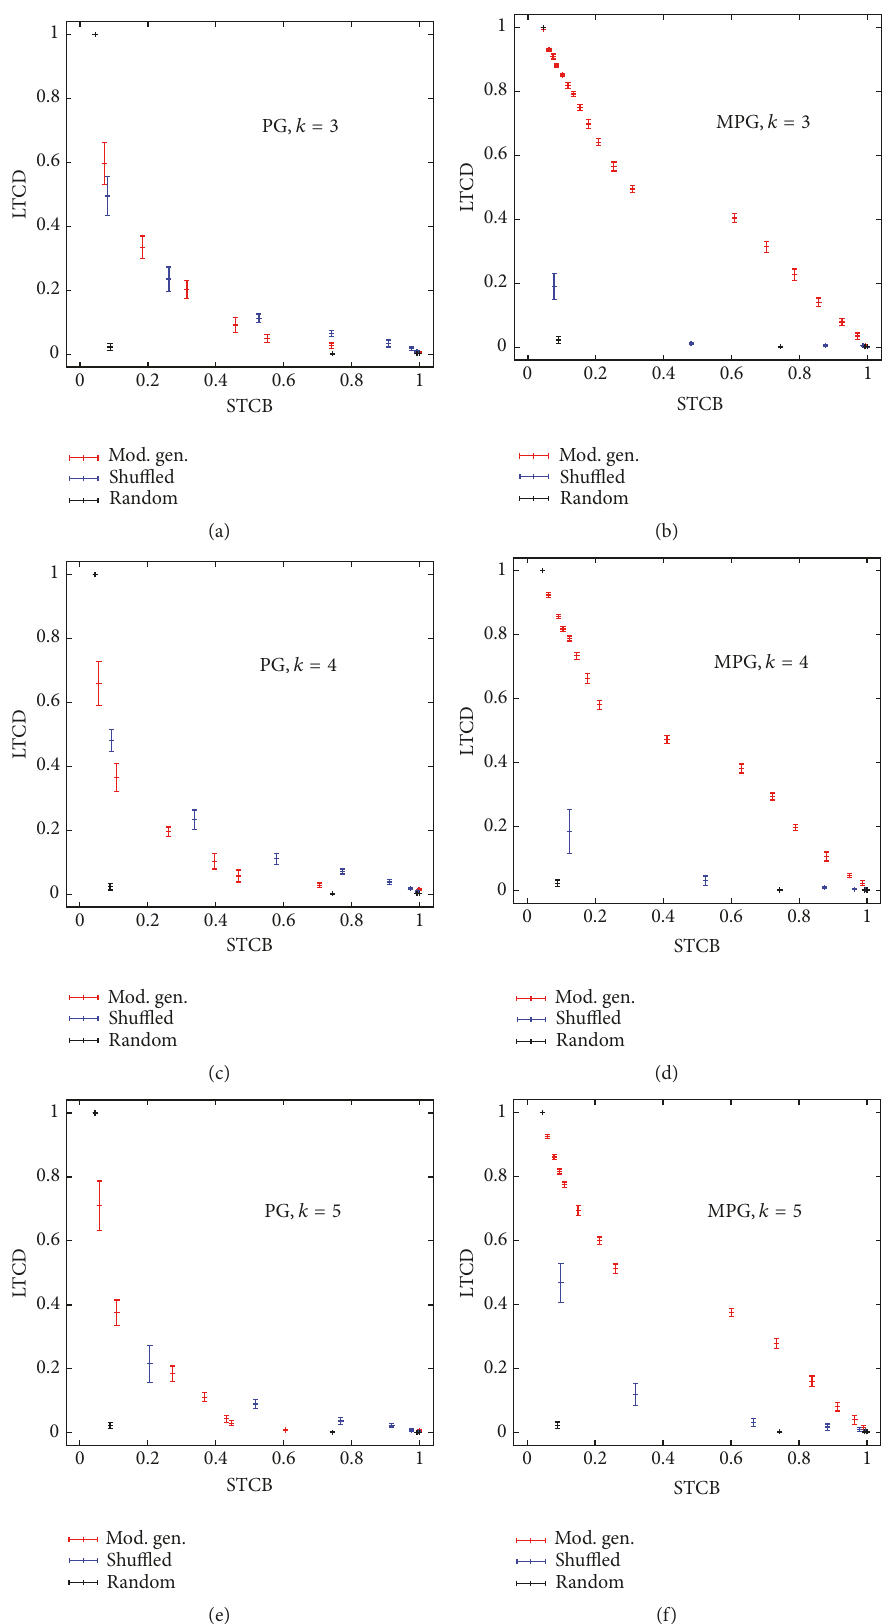
Figure4:Thecorrespondencebetweenlong-termculturaldiversity(LTCD)andshort-termcollectivebehavior(STCB)foramodel-generated (red), a shuffled (blue), and a random (black) SCV obtained via the PG model (a, c, e) and MPG model (b, d, f), for 𝑘 = 3 (a, b), 𝑘 = 4 (c, d), and 𝑘 = 5 (e, f) prototypes. Error bars denote standard deviations over multiple trait dynamics runs. There are 𝑁 = 500 elements in each set of cultural